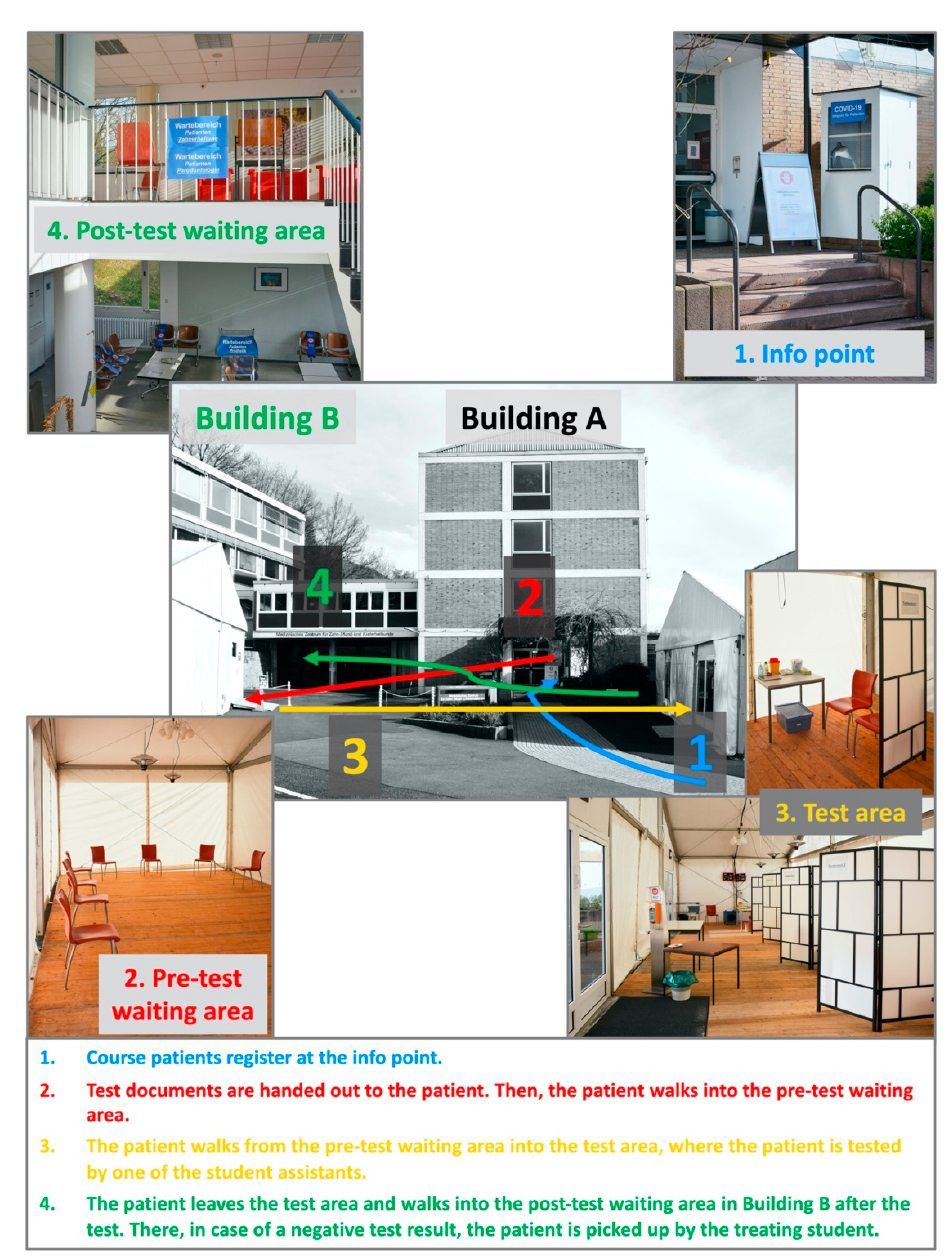
Figure 1. Setup of the patients’ waiting and test area in front of the dental clinic.